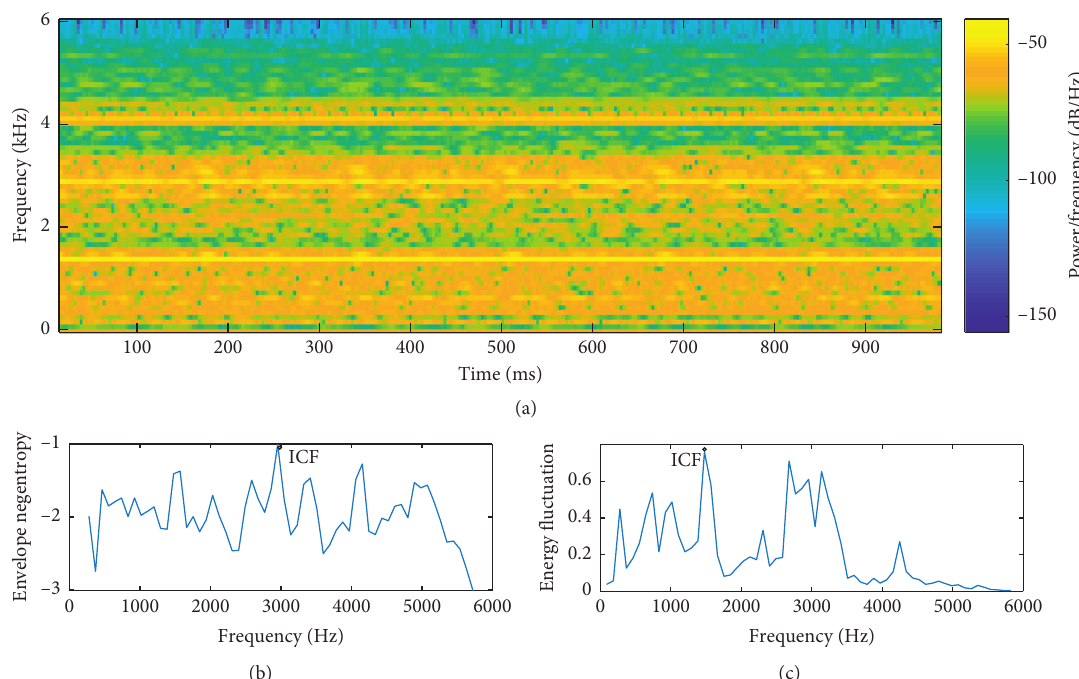
Figure 23: Spectral analysis of the experimental data in Figure 21(a) at window length 384 and overlap rate 90%: (a) TFR, (b) ENS, (c) EFS. –0.200.2